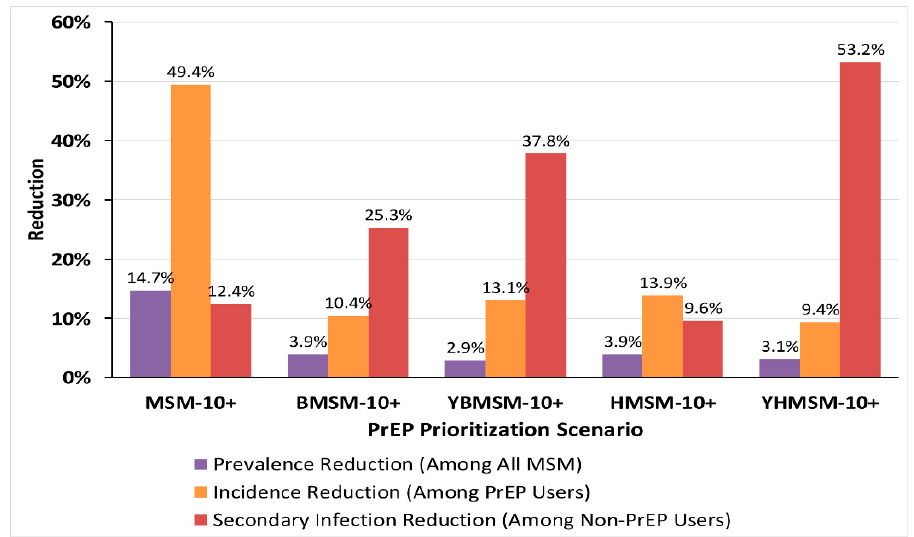
Figure 3. Reduction in the HIV prevalence, incidence, and secondary infections under